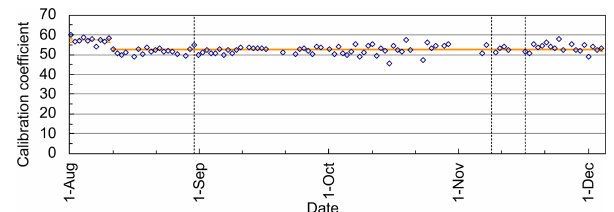
Figure 4. Temporal variation in the calibration coefficient of the water vapor mixing ratio ( K ) for the MRL obtained by comparison with collocated radiosonde measurements at 20:30LST from Au- gust to December 2016. The horizontal orange lines show the aver- ages before and after 12 August. The vertical dotted lines indicate dates on which the optical axis was